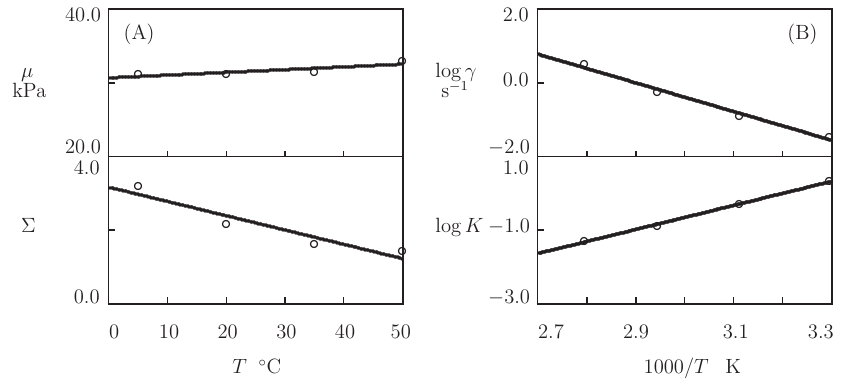
Figure 15. Parameters µ , Σ ( A ) and γ , K ( B ) versus temperature T . Circles: treatment of observations on P 4 gel. Solid lines: the results of